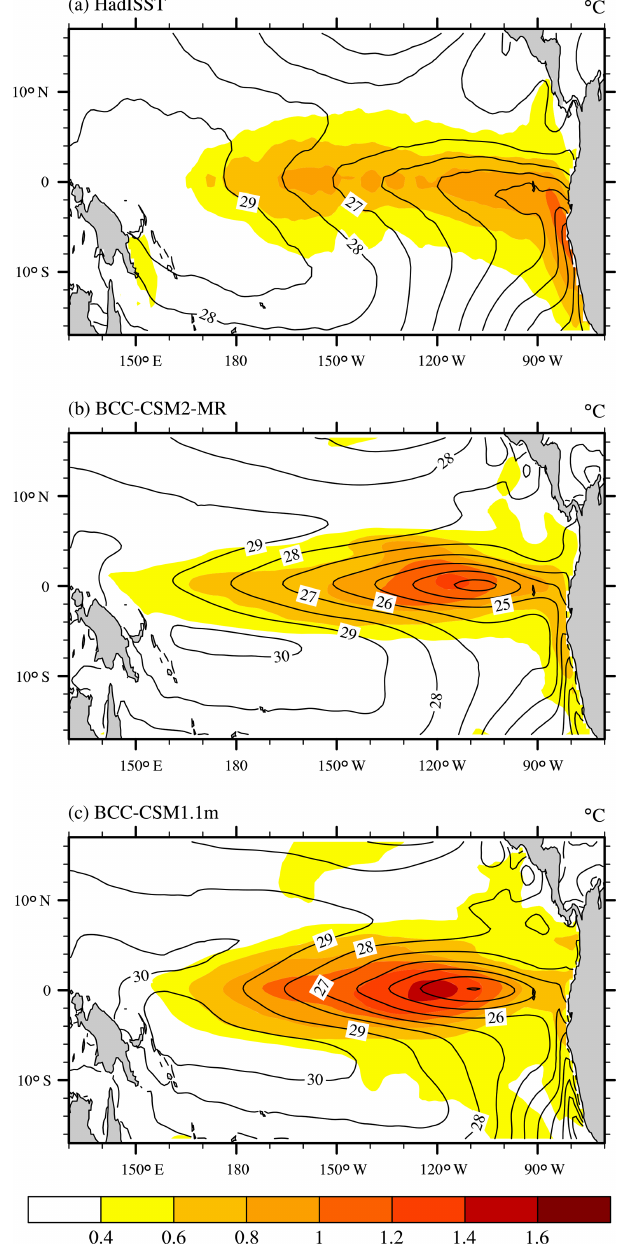
Figure 12. The spatial distributions of the 1986–2005 annual mean sea surface temperature (contour lines, ◦ C) and the standard devi- ations of the interannual anomalies (shaded area, ◦ C) in the trop- ical Pacific for (a) HadISST observations (Rayner et al., 2003), (b) BCC-CSM2-MR, and (c) BCC-CSM1.1m.